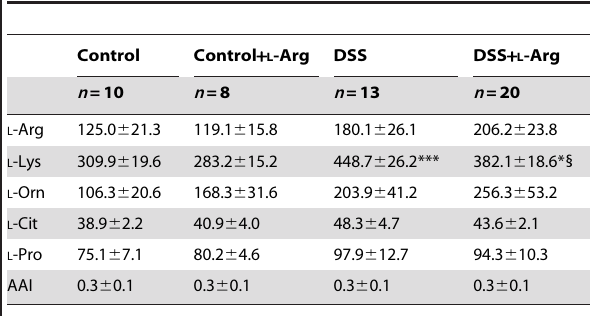
Table 1. Amino acids in the serum from DSS colitis in the presence or absence of L-Arg.